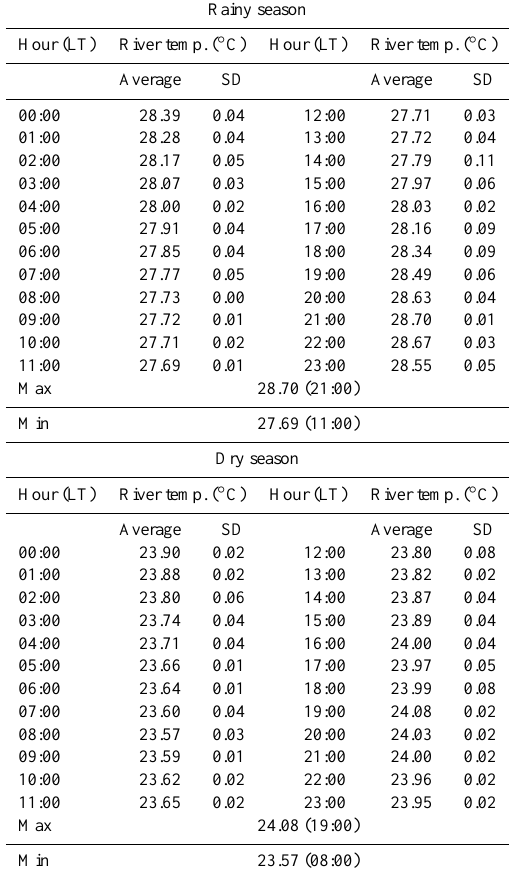
erals, and the direct pumping of root respiration CO 2 Table 3. Average of the hourly temperature profile collected by the thermistor chain located at station S05 (river) on 29 February 2012 (rainy season) and 20 September 2012 (dry season). Rainy season